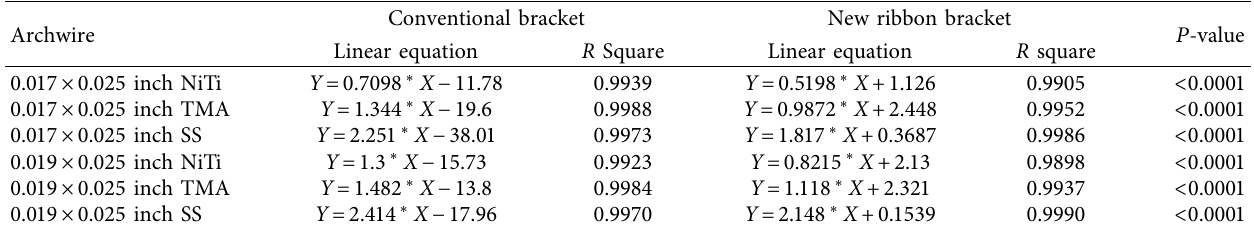
Table 3: Comparison of the linear equations, moment, and angle in each group for different bracket types. Archwire